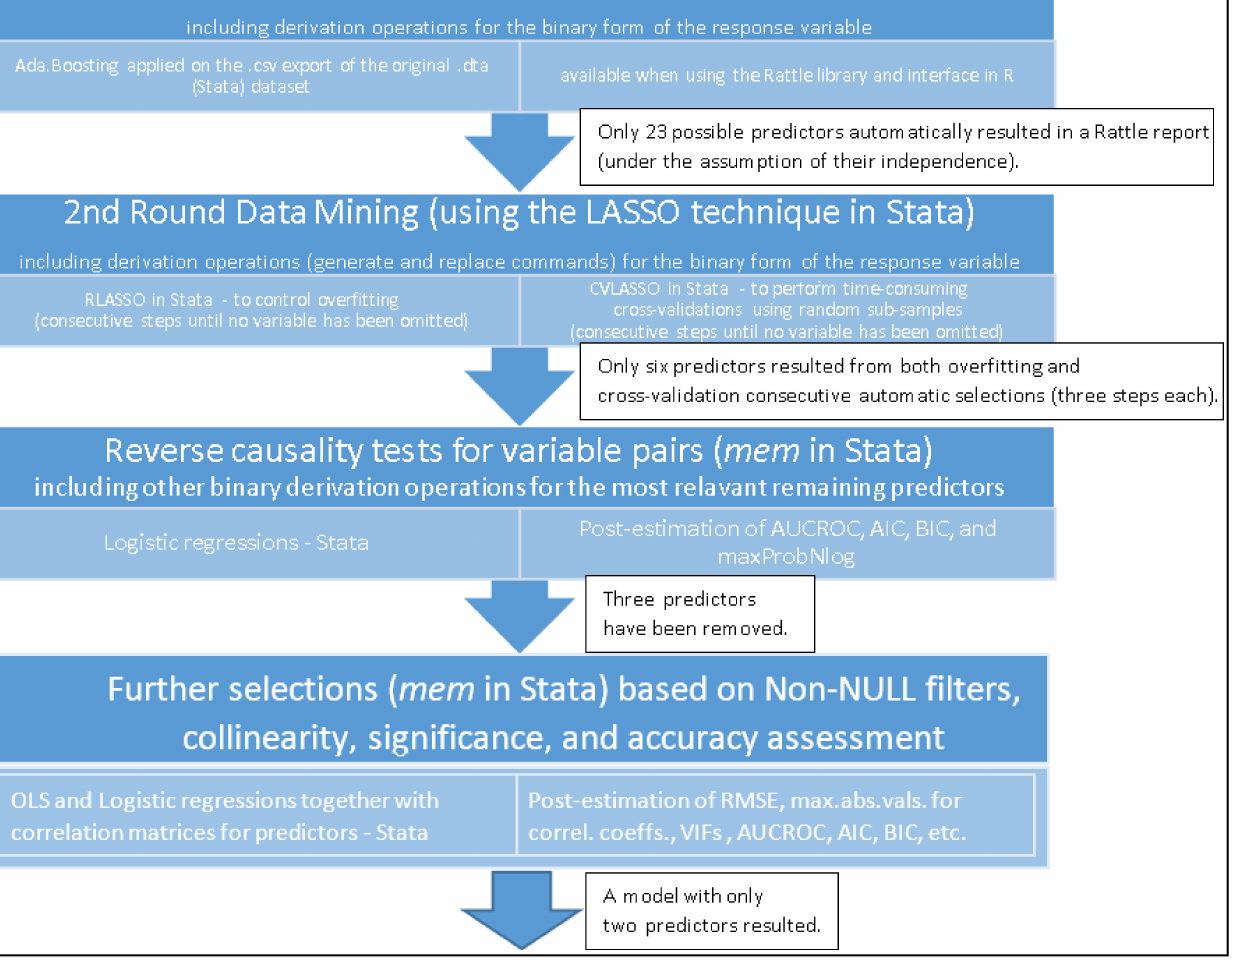
Figure A1. Schematic illustration of the techniques used. Source: The authors’